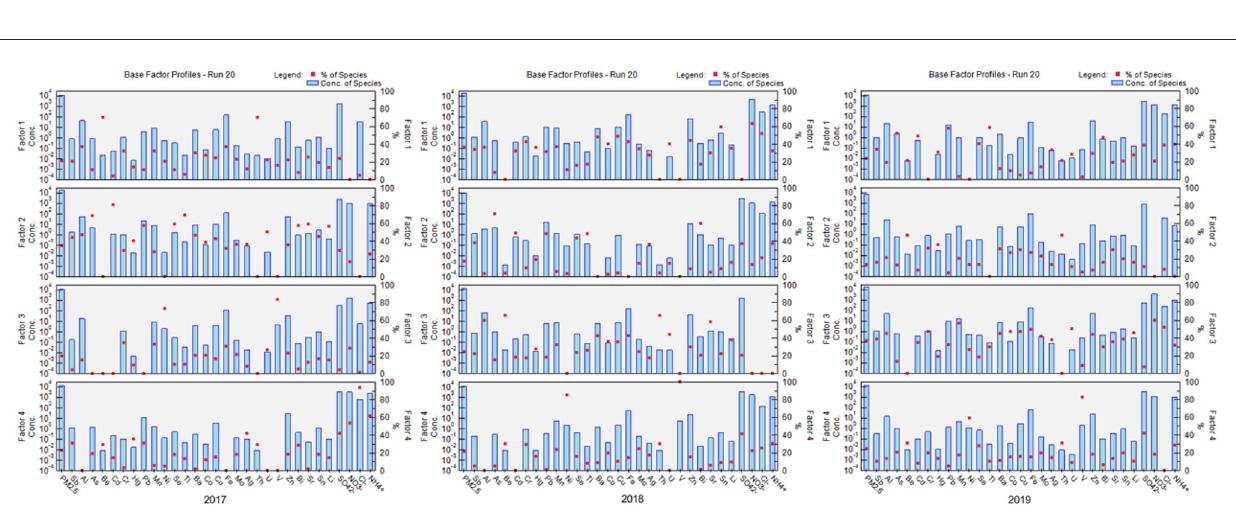
from 2017 to 2019. These results reveal that the six potential sources chosen by the model were street dust, motor vehicles, ships and heavy oil, secondary nitrates, boiler combustion, and aerospace